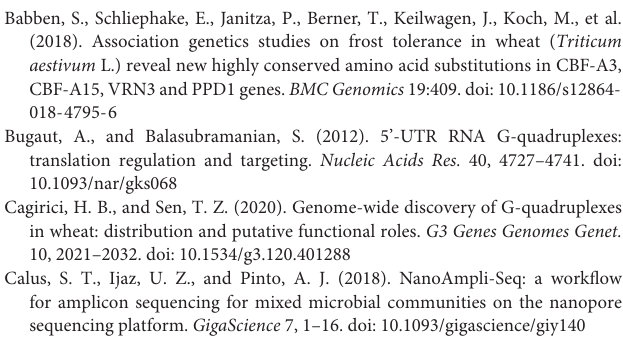
Supplementary Table 3 | KASP primer sequences for